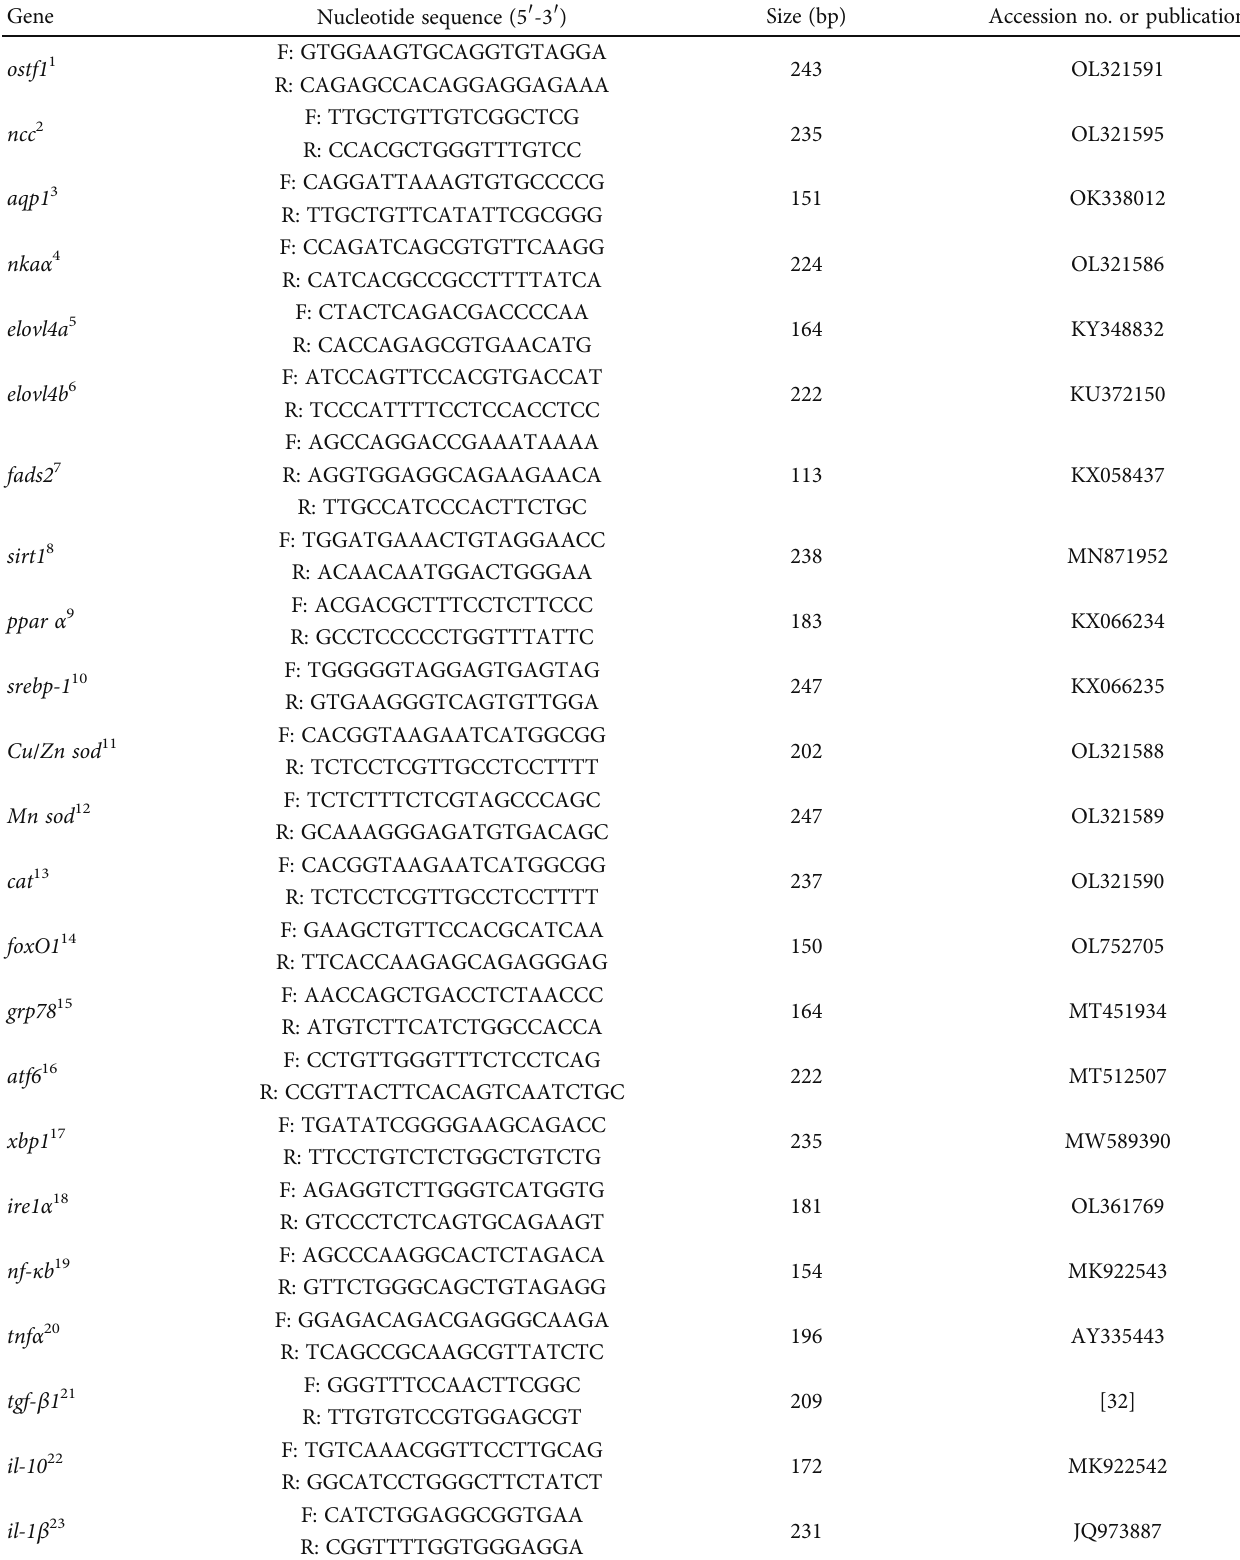
Table 3: Real-time quantitative PCR primers for genes and β -actin of juvenile black seabream ( Acanthopagrus schlegelii ).